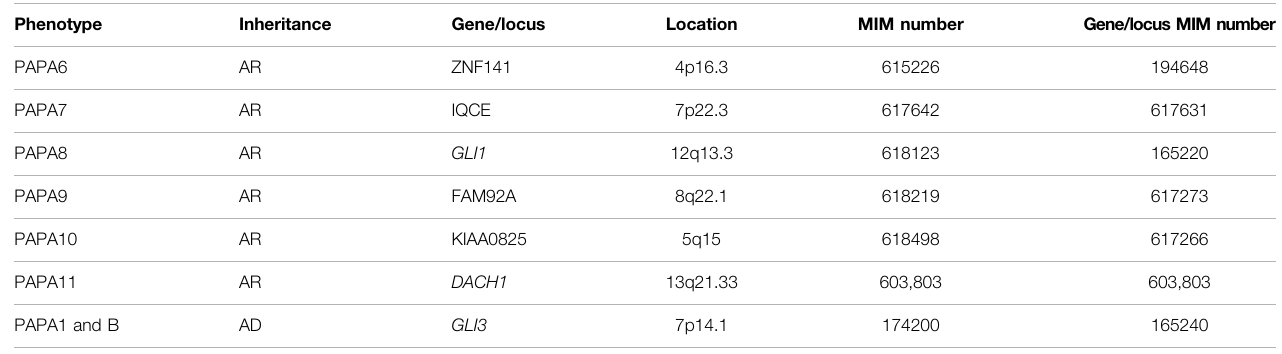
TABLE 1 | List of genes reported for isolated recessive PAPA until